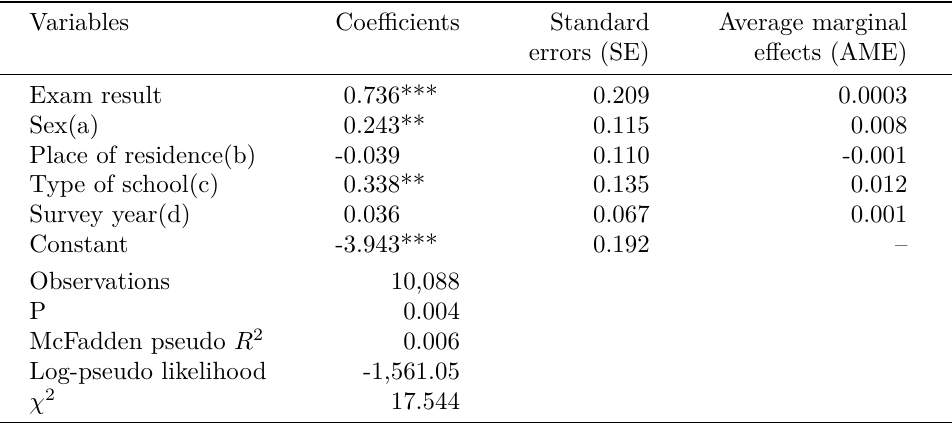
Table 4: Logit regression model results for international